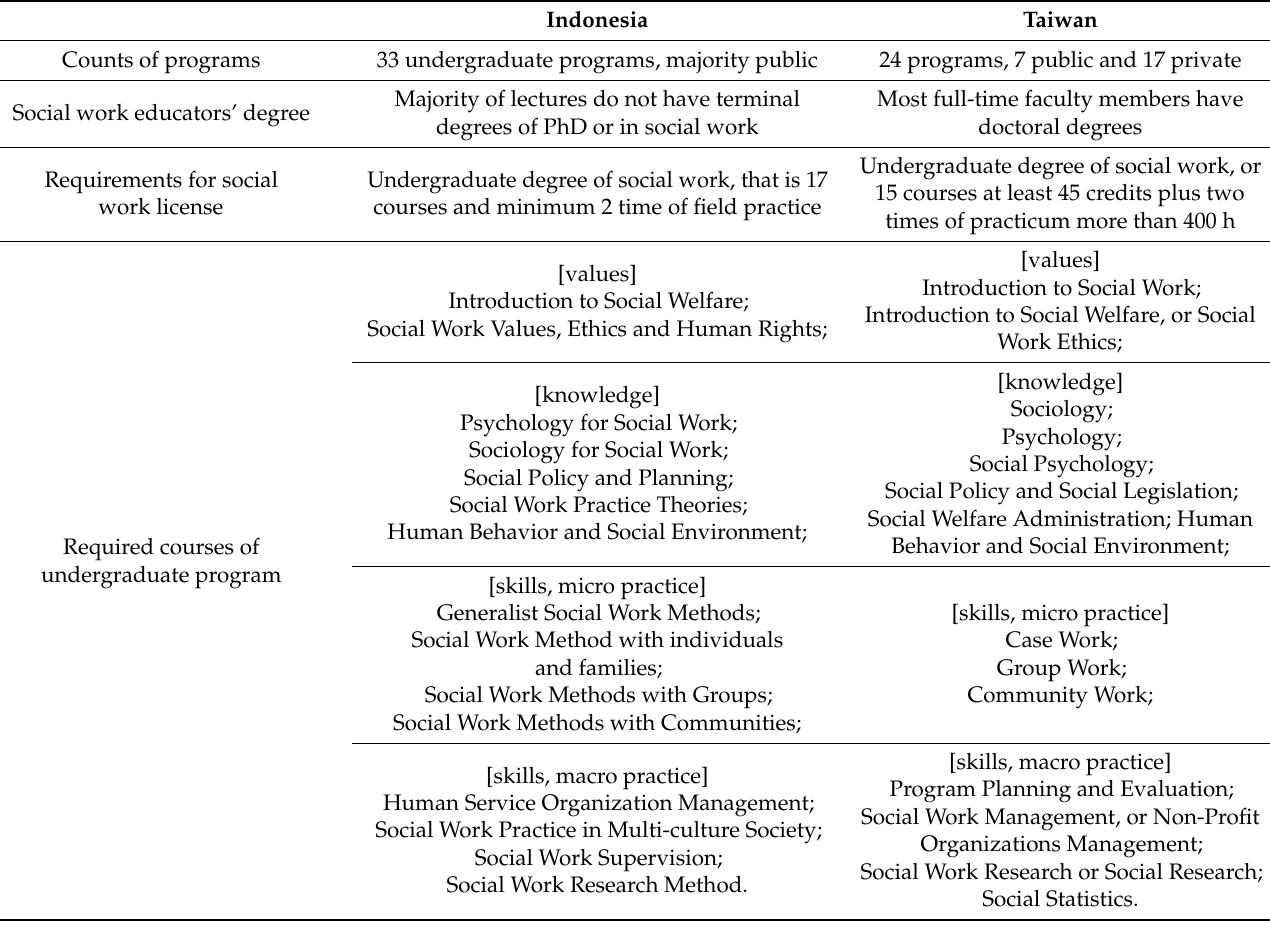
Table 1. Comparison of Social Work Programs in Indonesia and